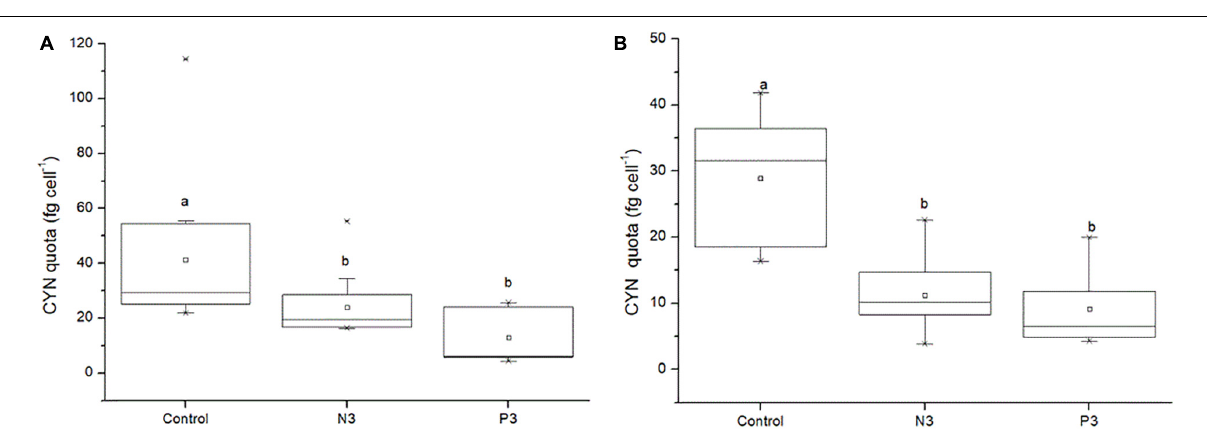
FIGURE 8 | CYN quotas of R. raciborskii CS506 (A) and QDH7 (B) under BG11 control, N-limited (N3) and P-limited (P3) conditions in CS506/CS510 and QDH7/N8 pairwise co-culture experiments. Boxes represent 25th to 75th percentiles, horizontal line within box marks the median, and open square within box indicates the mean. Whiskers below and above the boxes indicated 10th and 90th percentiles, and asterisks represent 1th and 99th percentiles. Letters denote significant differences among